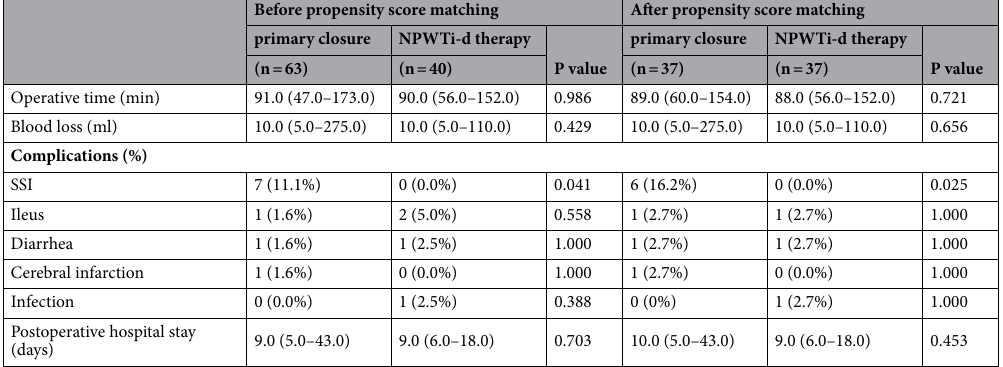
Table 2. Postoperative outcomes. SSI , Surgical site